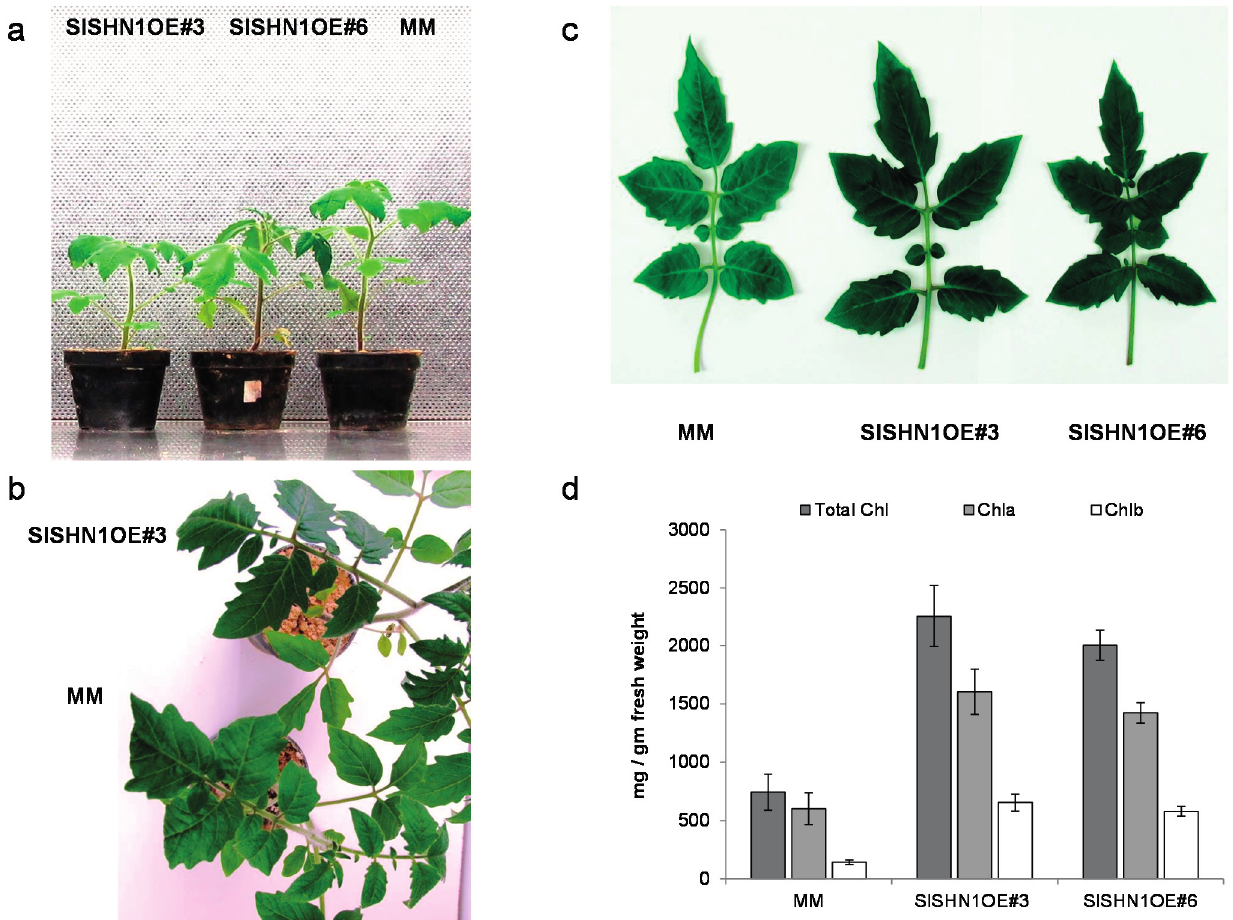
Figure 3. ( a ) Growth performance of two-week old tomato seedlings of two transgenic lines over-expressing SlSHN1 ( SlSHN1OE#3 and SlSHN1OE#6 ) and wild type (MM) under normal conditions; ( b ) The shiny appearance of the transgenic line over-expressing SlSHN1 ( SlSHN1OE#3 ) compared with wild type plant; ( c ) The dark green color phenotype of leaves in transgenic lines over-expressing SlSHN1 ( SlSHN1OE#3 and SlSHN1OE#6 ) compared with wild type leaf (MM); ( d ) Total chlorophyll (total Chl), Chlorophyll a (Chla) and Chlorophyll b (Chlb) content in two transgenic lines over-expressing SlSHN1 ( SlSHN1OE#3 and SlSHN1OE#6 ) and wild type leaves